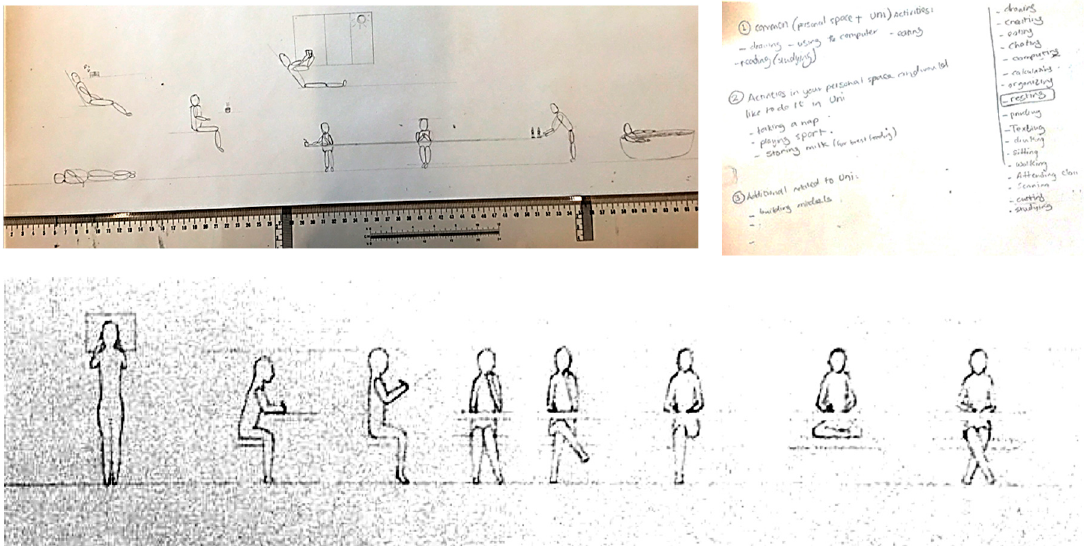
Figure 8. Activity—Human posture brainstorming.